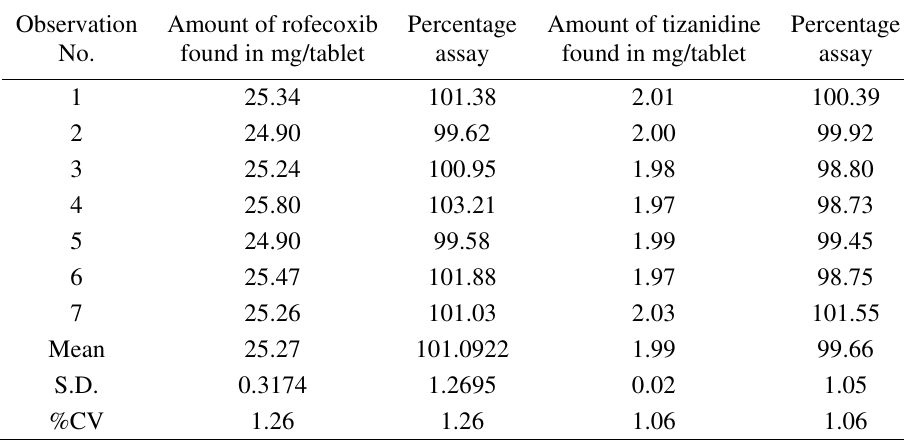
Table 2 . Results of assay